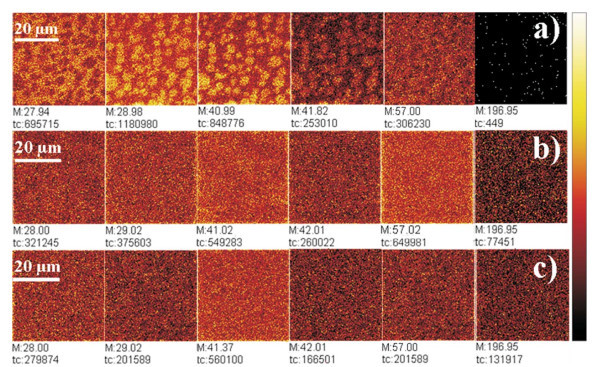
ToF SIMS chemical maps of each deposition step of as deposited and annealed samples: (a) TOF-SIMS chemical maps of the HP-LB film of PnBuA-b-PAA; (b) TOF-SIMS chemical maps of the HP-LB film of PnBuA-b-PAA covered with Au nanoparticles deposited by sputtering; (c) TOF-SIMS chemical maps of the annealed bilayer (115°C, 15 min) composed by HP-LB film of PnBuA-b-PAA covered with Au nanoparticles deposited by sputtering.